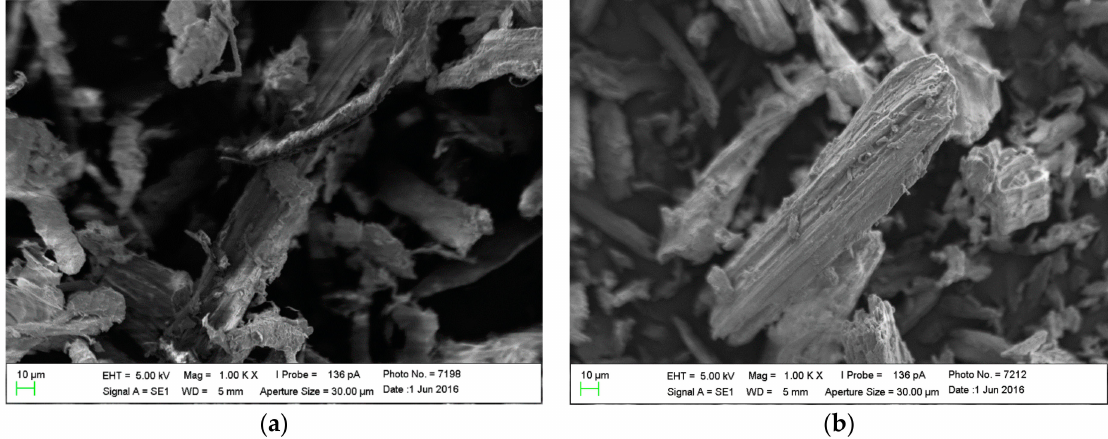
Figure 3. Micrographs of the sisal fiber: in natura ( a ) and treated ( b ). EHT: electronic acceleration; Mag: magnification; SE1: secondary electron detector; WD: working